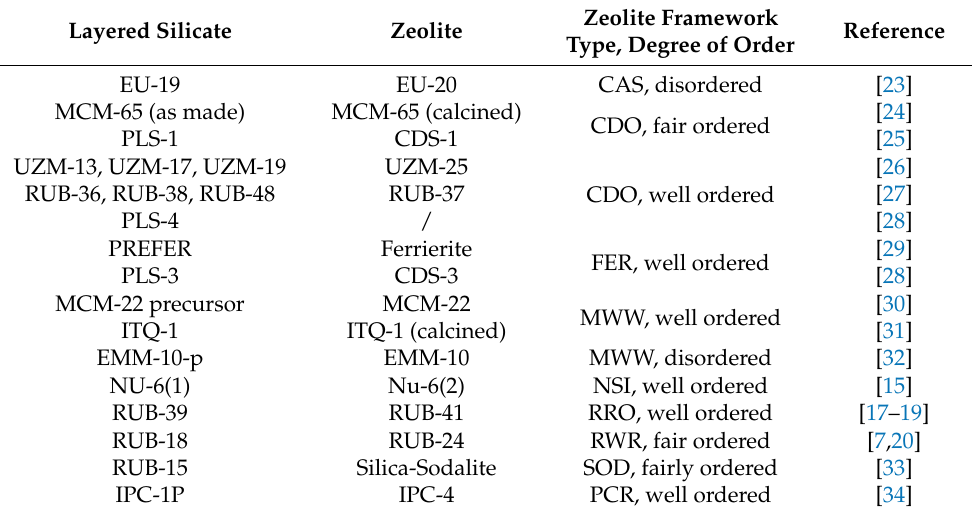
Table 1. The published zeolite synthesis via topotactic condensation of layered silicates. Reprinted with permission from ref. [22]. Copyright 2012, Schweizerbart Science